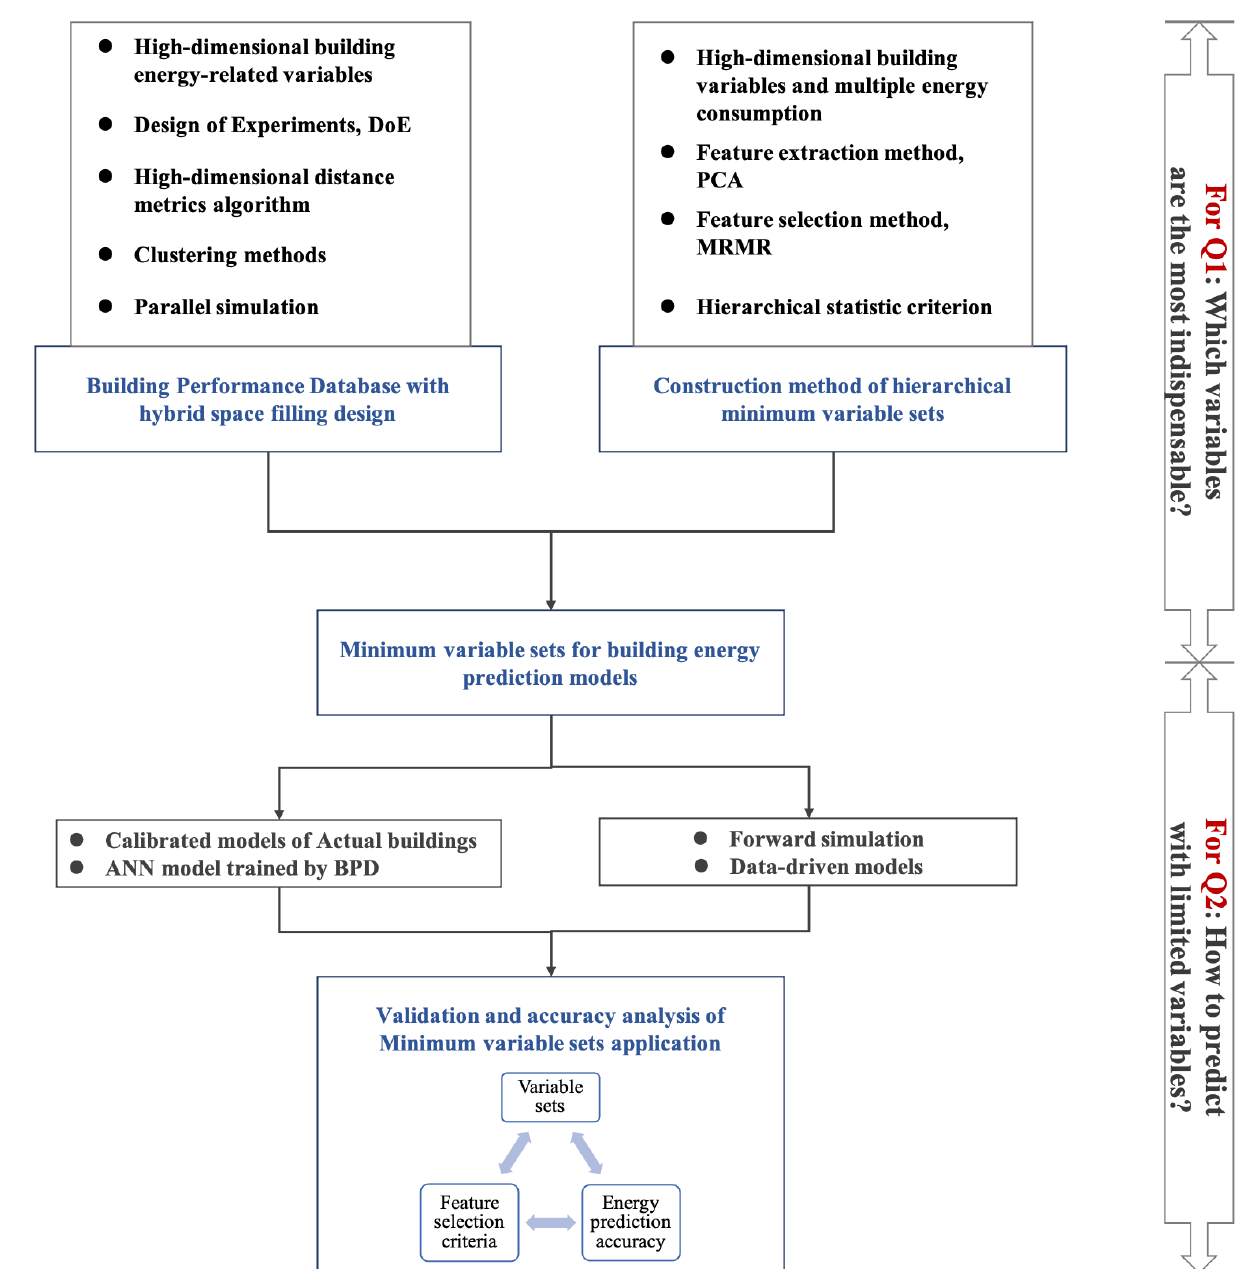
Figure 1. Research framework of minimum variable sets (MVS) for building energy-prediction models.